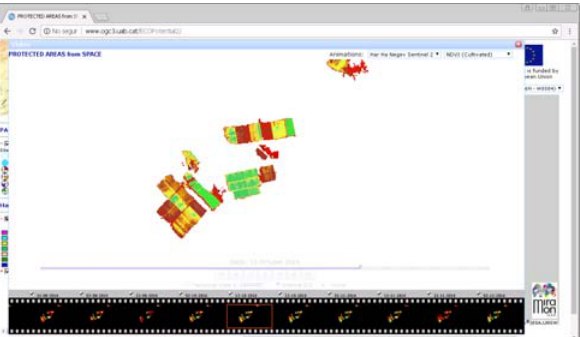
Figure 15. Time series video for the Sentinel-2 NDVI on the small area of the terrestrial cultivated LULC category.